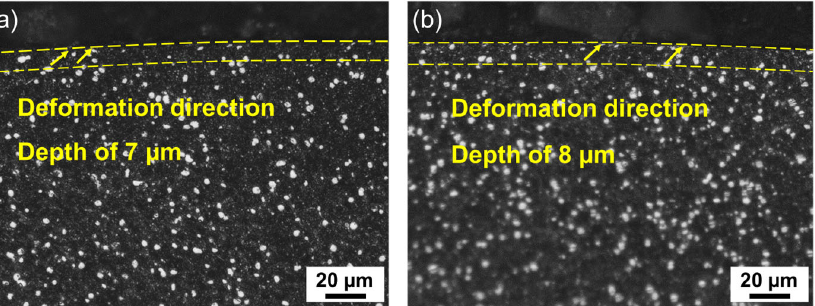
Figure 9. Cross-section microstructure of the turned surface using CCI: ( a ) conventional cu tt ing and ( b ) 0.90 A/mm 2 .